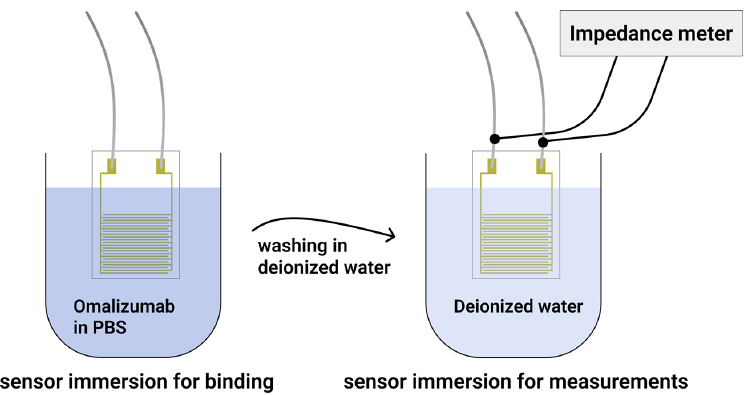
Figure 5. Schematic presentation of the measurement procedure stages.